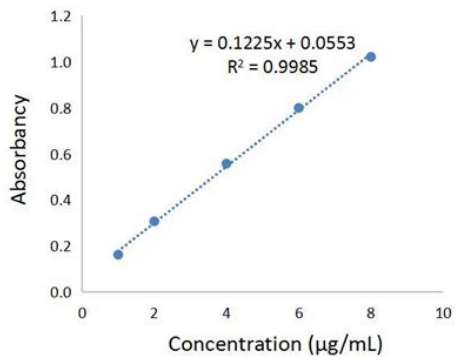
Figure 1. Gallic acid standard curve for the total phenolic acids content determination.